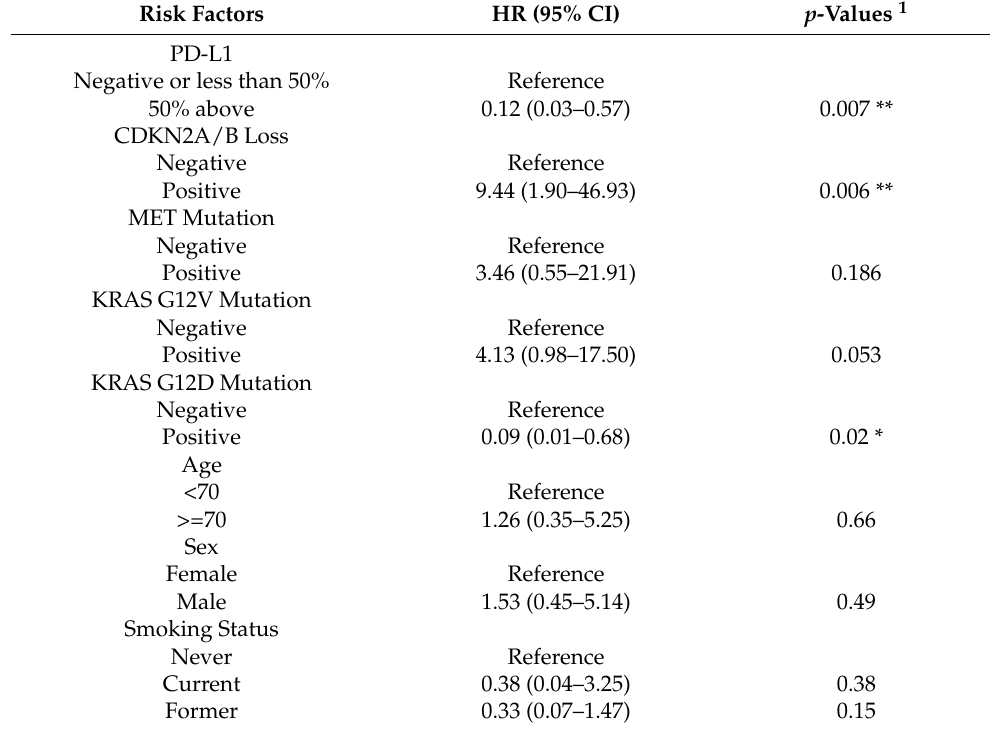
Table 3. Multivariate analysis for